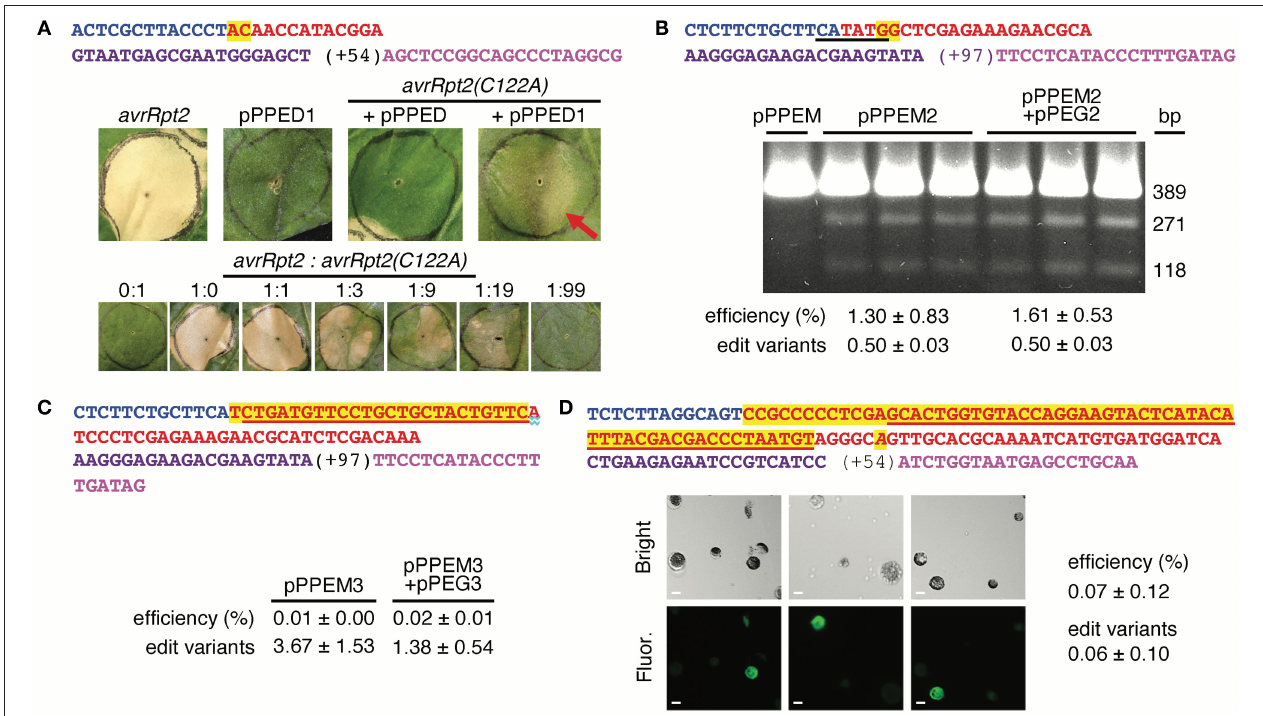
FIGURE 2 | Use of the vectors for spelling changes and tag insertions in three plant species. (A) A 2-bp edit of avrRpt2 ( C122A ) using agroinfiltration of Nicotiana benthamiana (N. benthamiana) leaves. Top, features of the pegRNA and sgRNA, colored as in Figure 1C . Middle, leaves 12 days after introduction of avrRpt2 (OD 600 = 0.05), or pPPED1, avrRpt2(C122A ) and empty pPPED, or avrRpt2(C122A ) and pPPED1 (each at final OD = 0.5). Bottom, leaves 6 days after infiltration of 600 different ratios of strains delivering avrRpt2 or avrRpt2(C122A) , both at OD 600 = 0.05 before mixing. These experiments were repeated twice and yielded results consistent with those shown. (B) A 2-bp substitution at OsSULTR3;6 in rice protoplasts. Top, pegRNA and sgRNA features with Bst Z17I site underlined. Below, Bst Z17I digests of a 389-bp fragment spanning the target amplified from protoplasts transfected with empty pPPEM, pPPEM2, or pPPEM2 and equimolar pPEG2; 271-bp and 118-bp cleavage products indicate the presence of the Bst Z17I site introduced by the edit. (C) A 25-bp insertion for FLAG tagging at OsSULTR3;6 . Top, pegRNA and sgRNA features, with FLAG coding sequence underlined. (D) A 60-bp insertion for fusion of GFP11 at AT1G26660.1 in